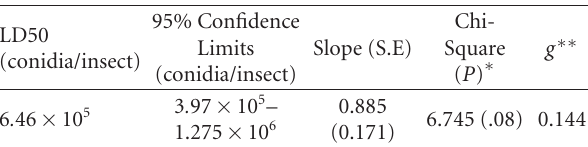
Table 1: Pathogenicity of Beauveria bassiana strain GHA for adult Anabrus simplex based on mortalities 21 days after topical application.